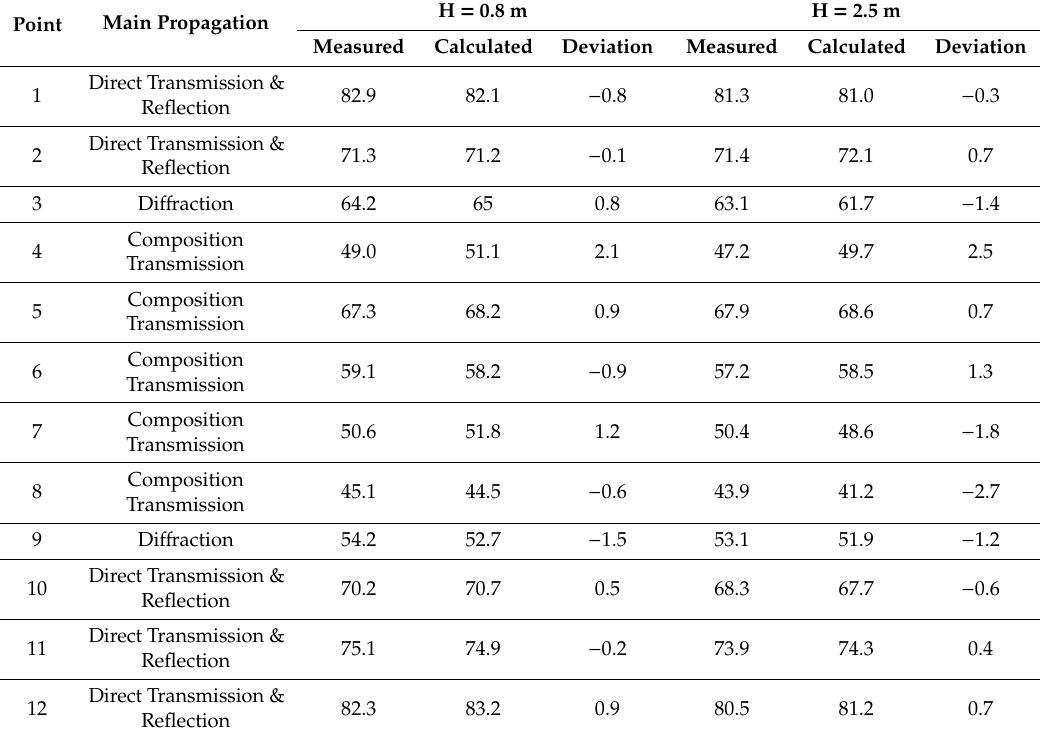
Table 1. Comparison of measured and calculated results (in